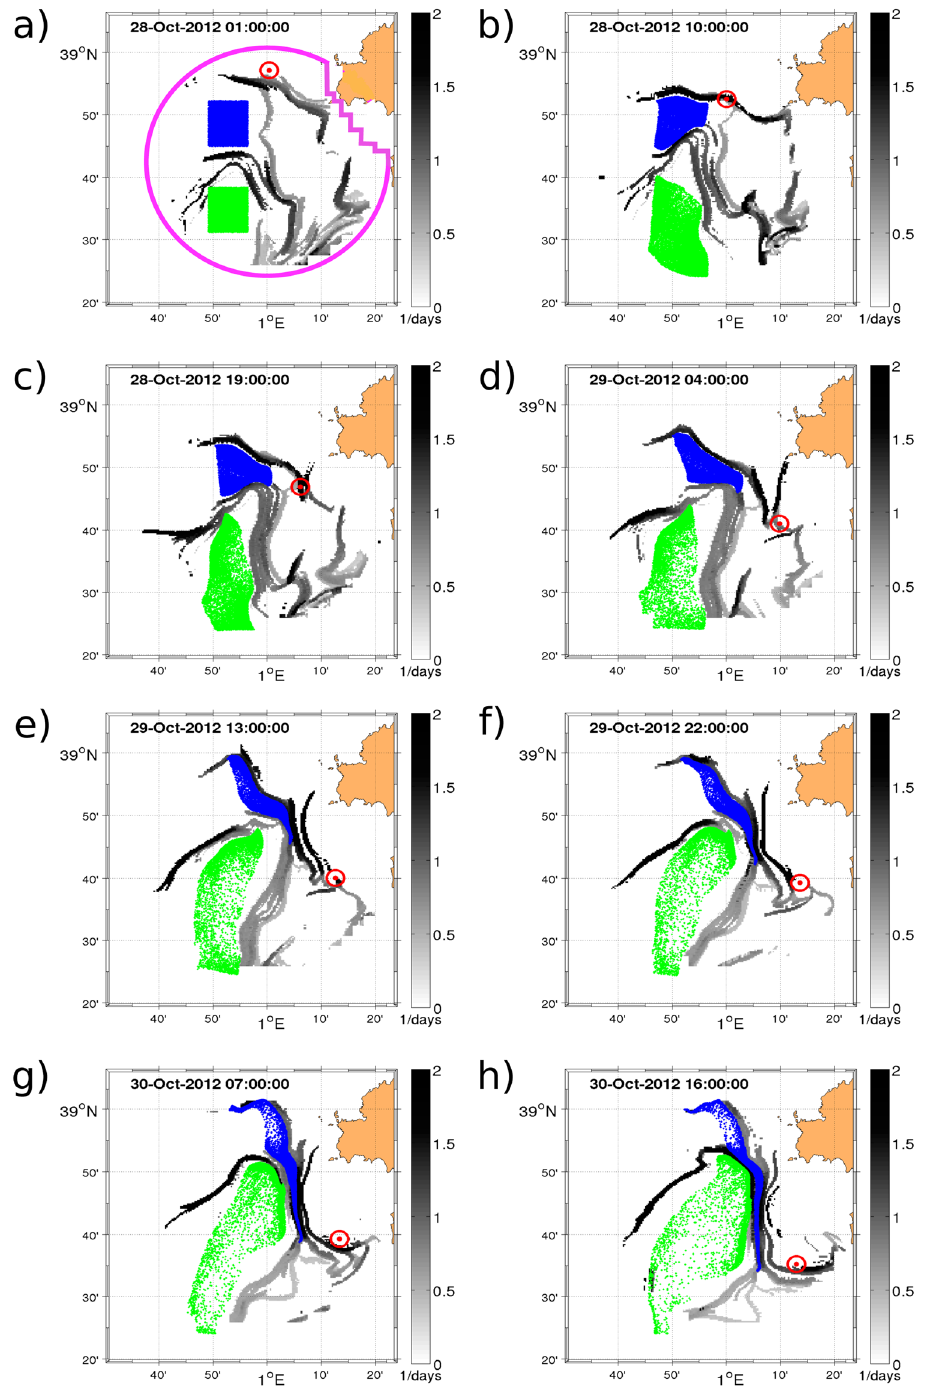
Figure 1. Evolution of two sets of particles (green and blue) and real drifter (red dot-circle) in the area covered by the HFR (magenta annotations in panel a) in October 2012 superimposed on the backward FSLE (grey colorbar). The virtual particles are initially deployed at both sides of a barrier revealed by a zonal LCS on October, 28th, 2013 at 00:00. The figure was made using MATLAB R2012a